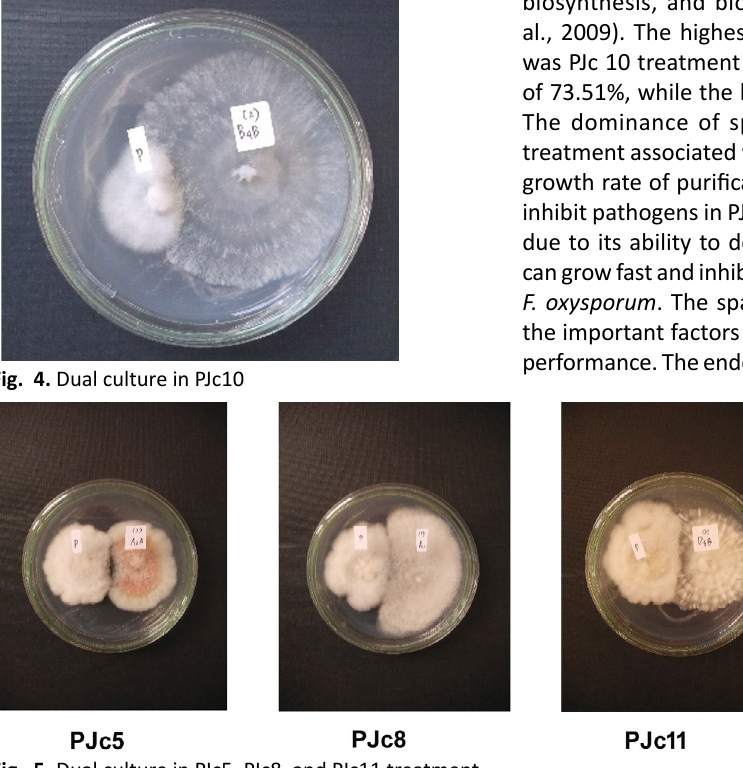
Fig. 5. Dual culture in PJc5, PJc8, and PJc11